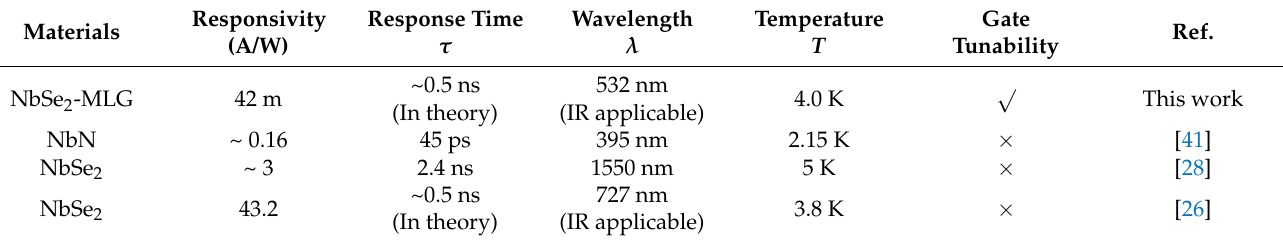
Table 1. Comparison between photodetectors based on